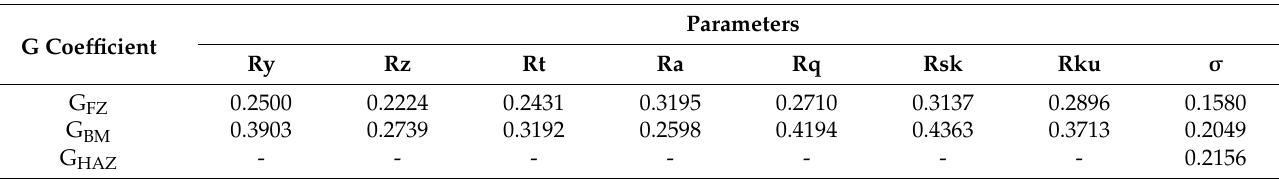
Table 5. The G values for the roughness parameters and residual stress σ .